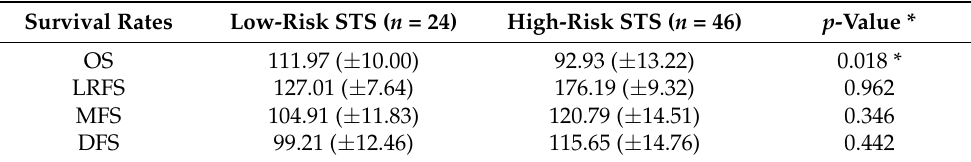
Figure 3. Kaplan–Meier curve of metastasis-free survival for ( a ) low-risk STS and ( b ) high-risk STS according to the therapeutic approach (PS vs. NT). Table 3. Kaplan-Meier means ( ± SE) for high-/low-risk STS in patients with NT ( n = 74).